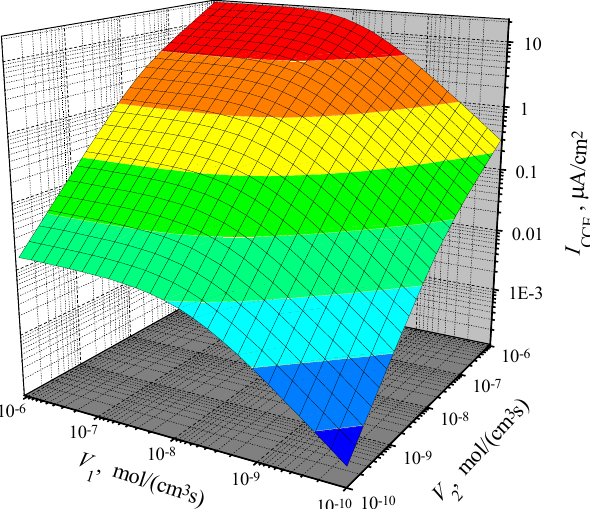
and V of the biosensor acting in CCE mode at the 1 2